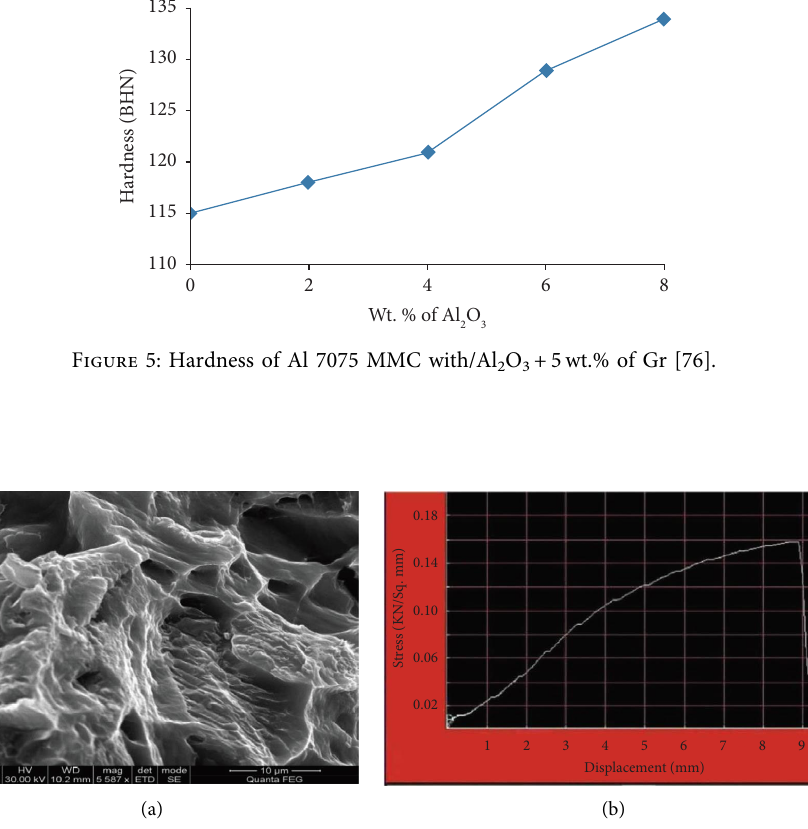
Figure 6: (a) SEM image of Al 7075 fractured surface. (b) Al 7075 stress-strain curve [80].